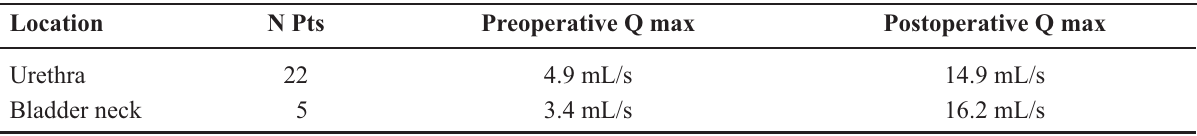
Table 2 – Mean Q max of patients that did not require a subsequent procedure depending on location of the stricture. Location